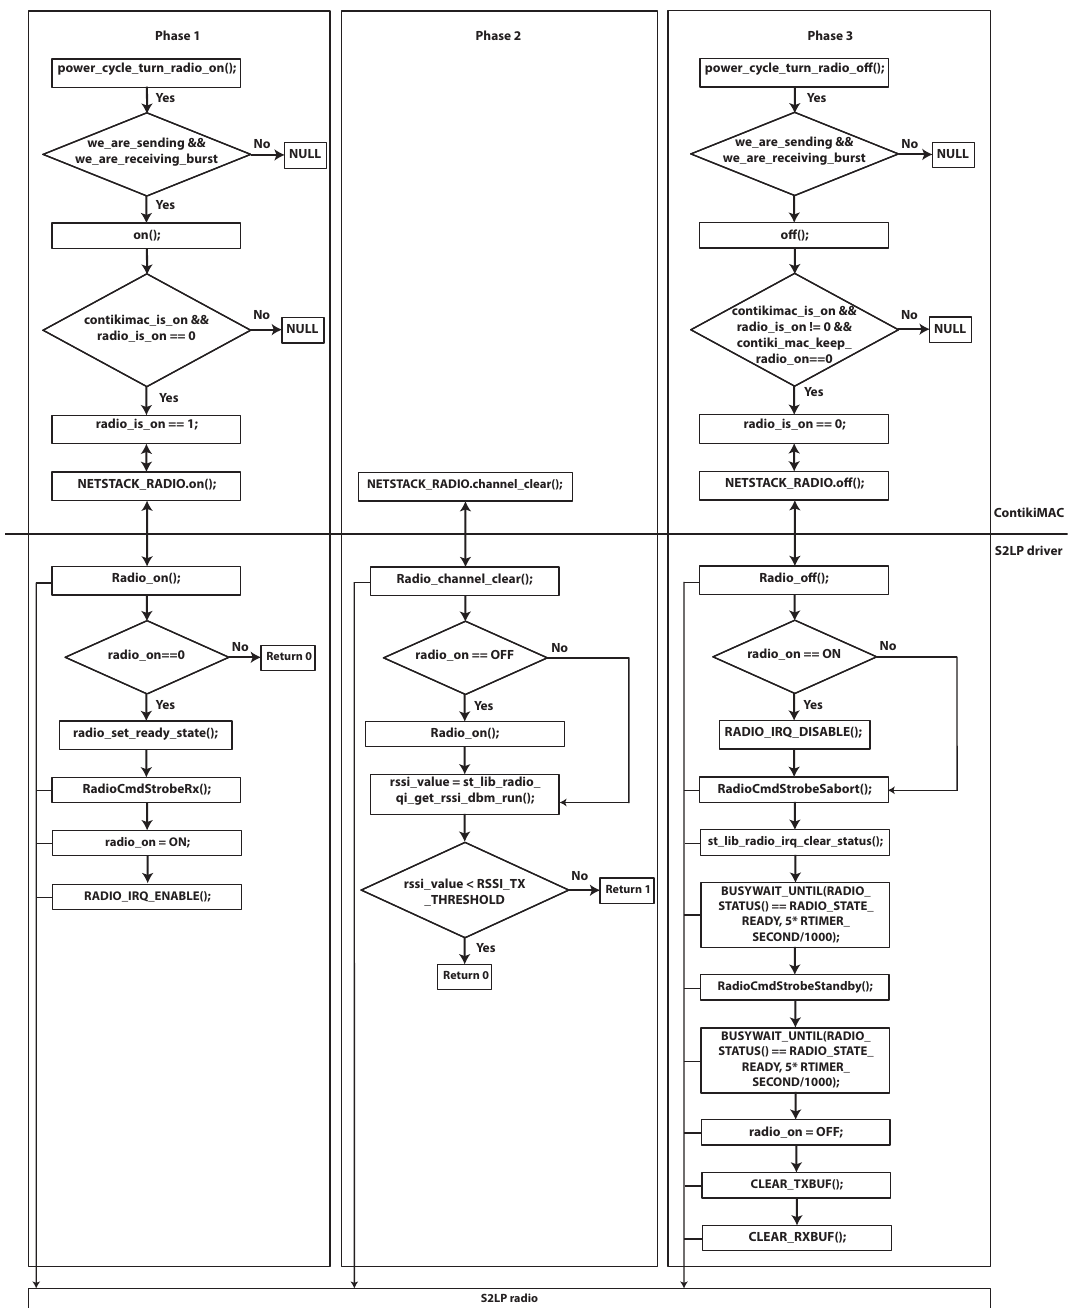
Figure 5. Relationship between contikiMAC RDC, S2LP radio deriver, and S2LP